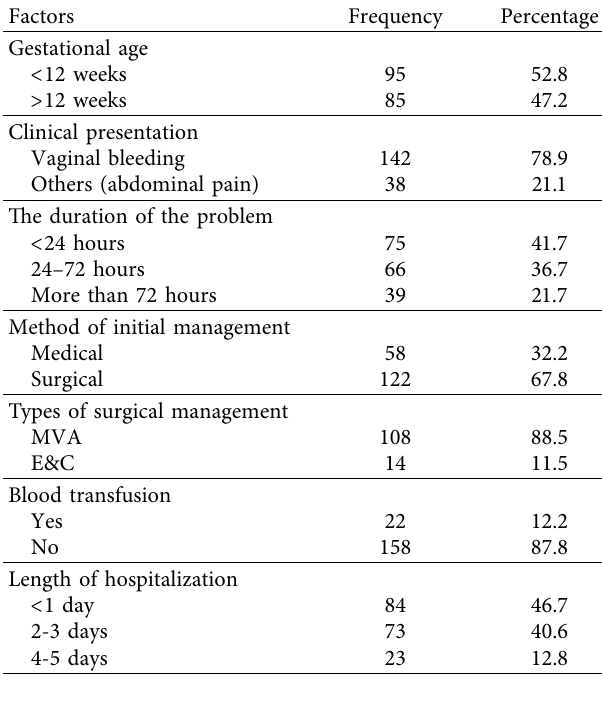
Table 1: Demographic and reproductive characteristics of women